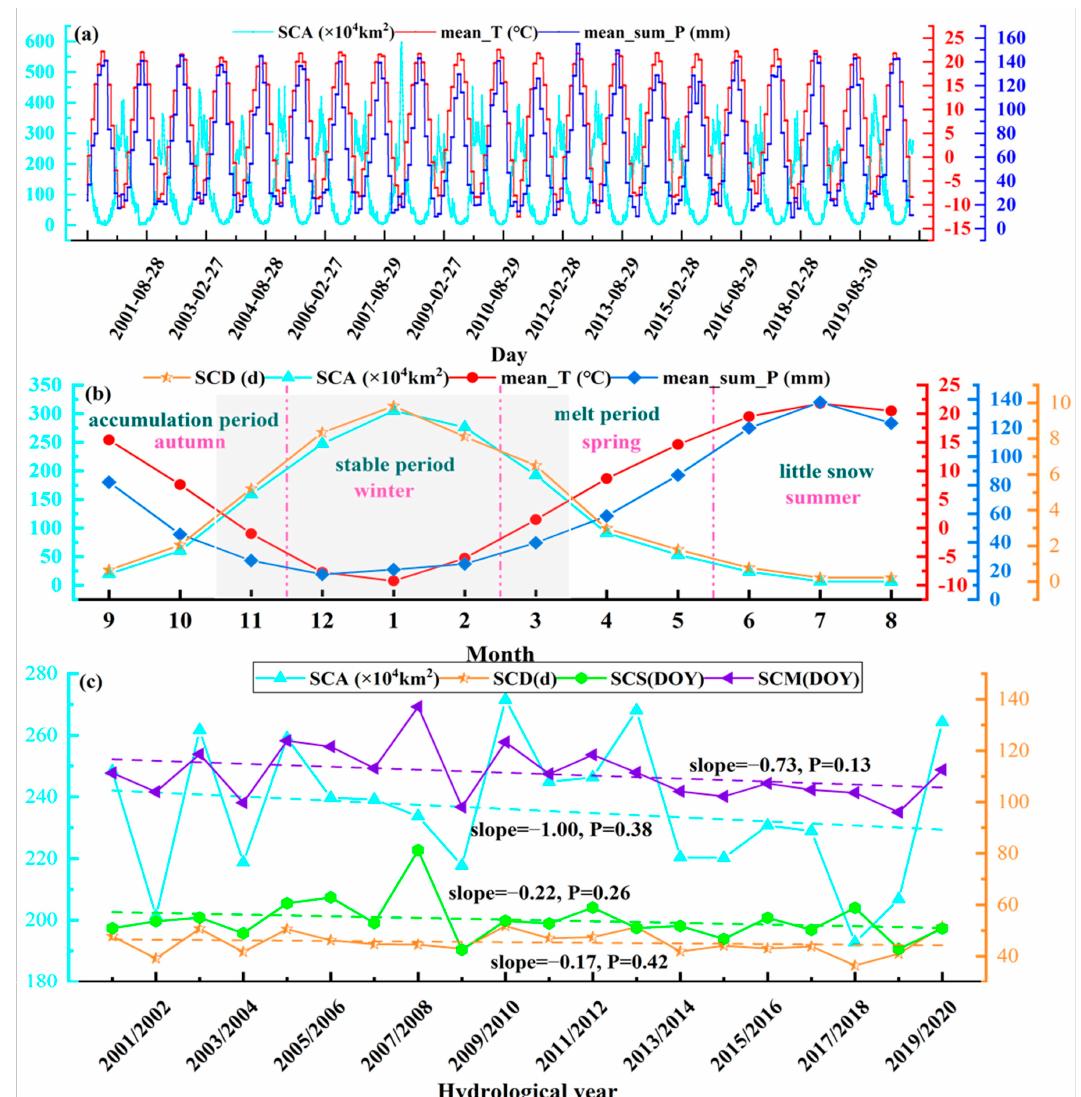
Figure 1. ( a ) Diurnal variation in average snow cover area (SCA), temperature, and total precipitation from 1 September 2000 to 31 August 2020, ( b ) monthly variations in average snow cover area (SCA), snow cover days (SCD), temperature, and total precipitation, ( c ) interannual variabilities of average snow cover area (SCA) and days (SCD), start (SCS), and melt (SCM) in China (CHN) from 2000/2001 to 2019/2020. The dotted line indicates parameters’ trend. Gray shade is snow season.